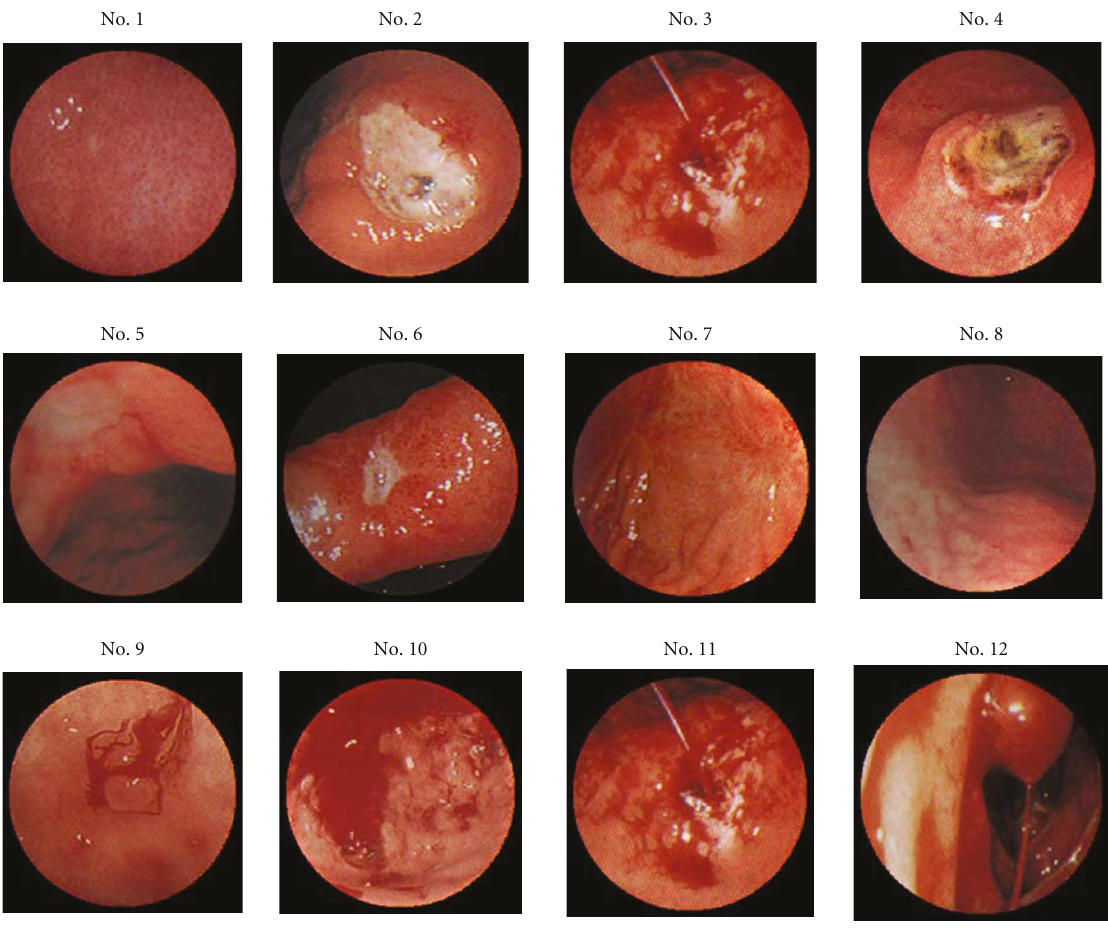
Figure 13: Demosaicked GI images.